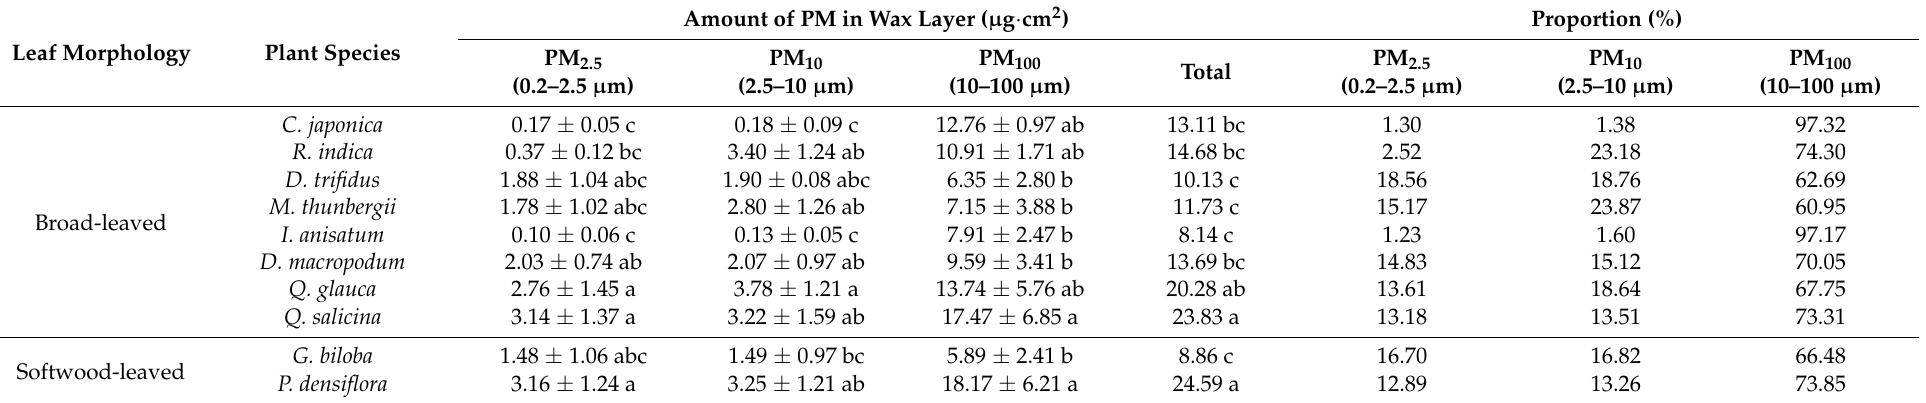
Table 4. Total amount of particulate matter (PM) accumulated in wax layer of leaves of the eight evergreen and two coniferous species by particle size. Data are mean ± SD with 5 replicates of 30 leaves each. Species marked with different letters are significantly different by Duncan multiple test ( p < 0.05).